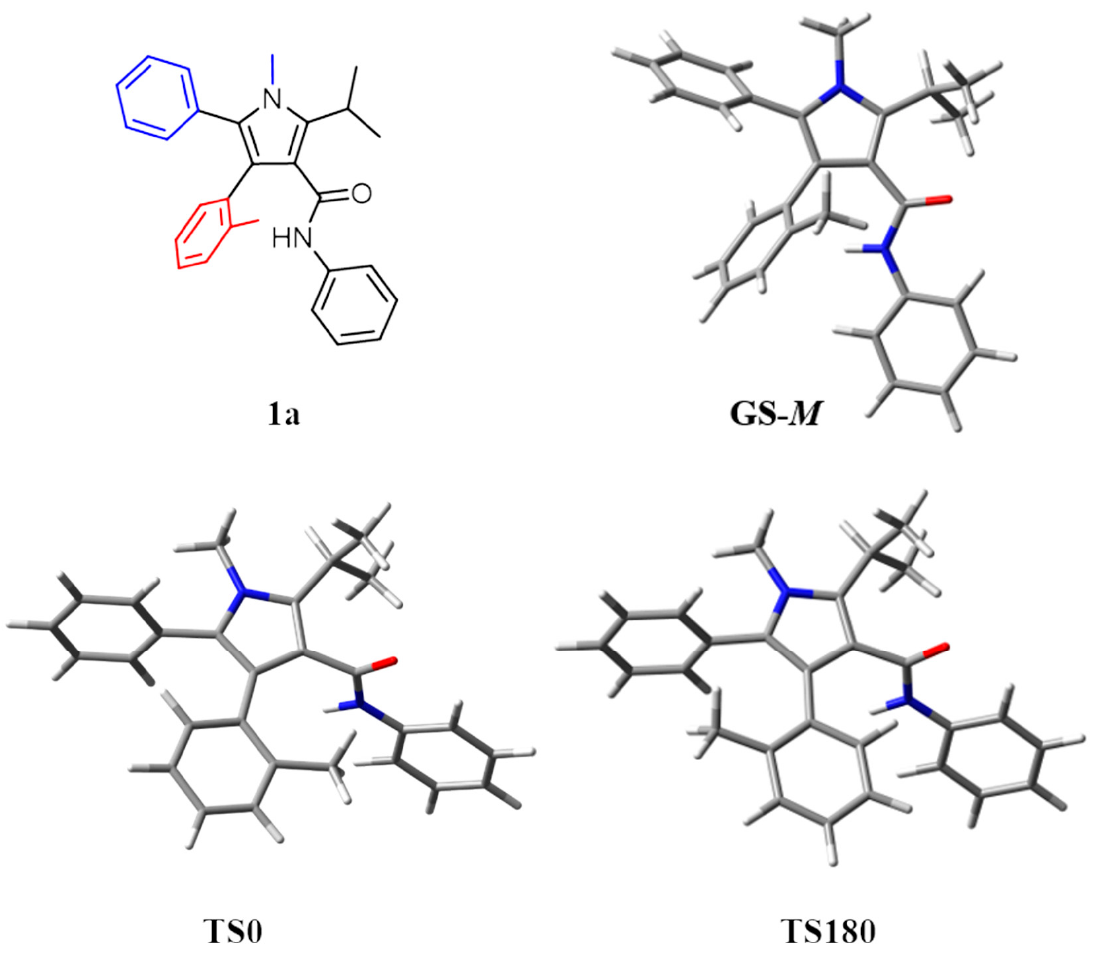
Figure 1. Ground and transition states for the rotation of the 3-tolyl group in 1a . Theoretical studies performed at the B3LYP-D3/6–31G(d) level of theory.